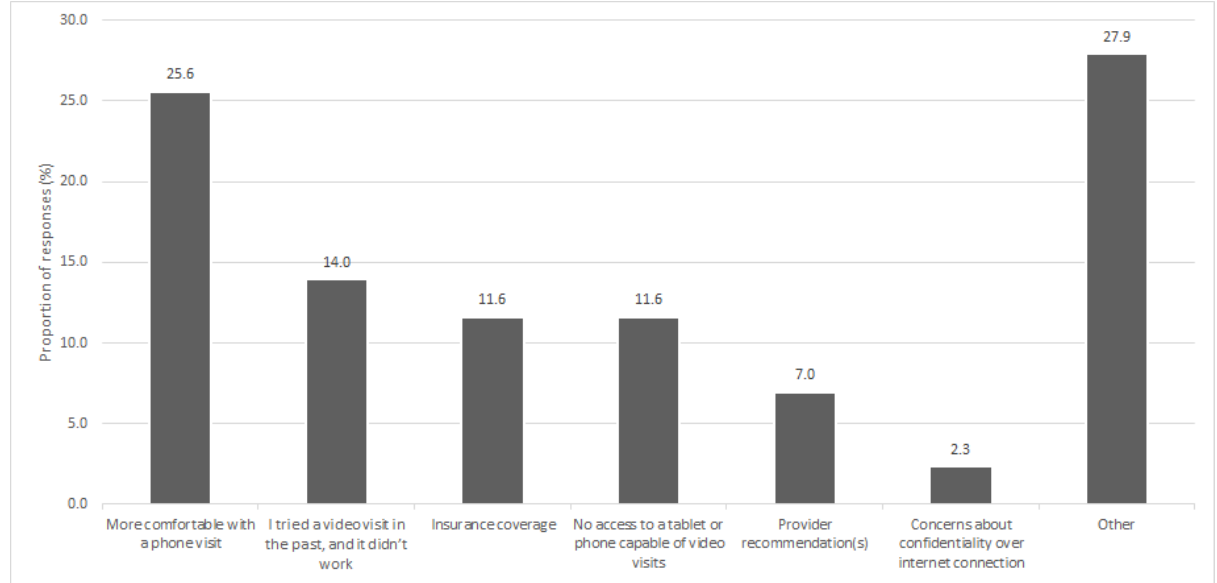
Figure 2. Factors influencing patients’decisions to receive care by telephone